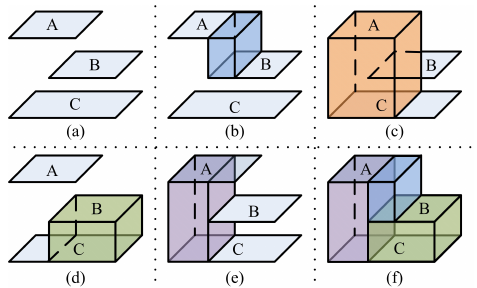
Figure 5. Example of trimming spaces.